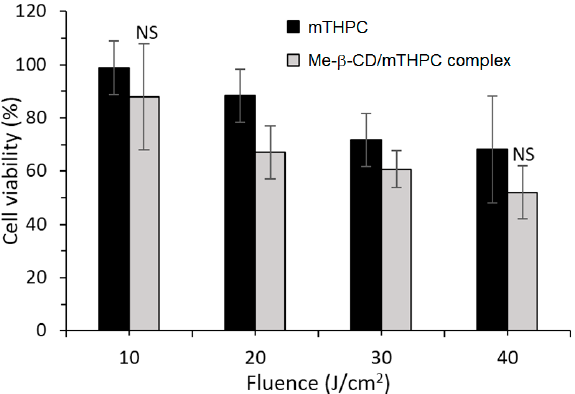
Figure 13. Cell viability of spheroids incubated 24 h with free mTHPC and Me- β -CD/mTHPC inclusion complex. The percentage of cell survival was counted by means of clonogenic assay 15 days after PDT. mTHPC concentration was 4.5 µM. Statistically different from mTHPC alone treatment at the given fluence, p < 0.05; NS: no significant differences from mTHPC alone treatment at the given fluence, p < 0.05. Adapted from Yakavets; Yankovsky; Millard; Lamy; Lassalle; Wiehe; Zorin; Bezdetnaya [128]. In 2017, Ikeda et al. [129] described the PDT effect of 2:1 inclusion complexes 1 – 6 of trimethyl- β -CD (TMe- β -CD) with different porphyrins, as described in Figure 14.